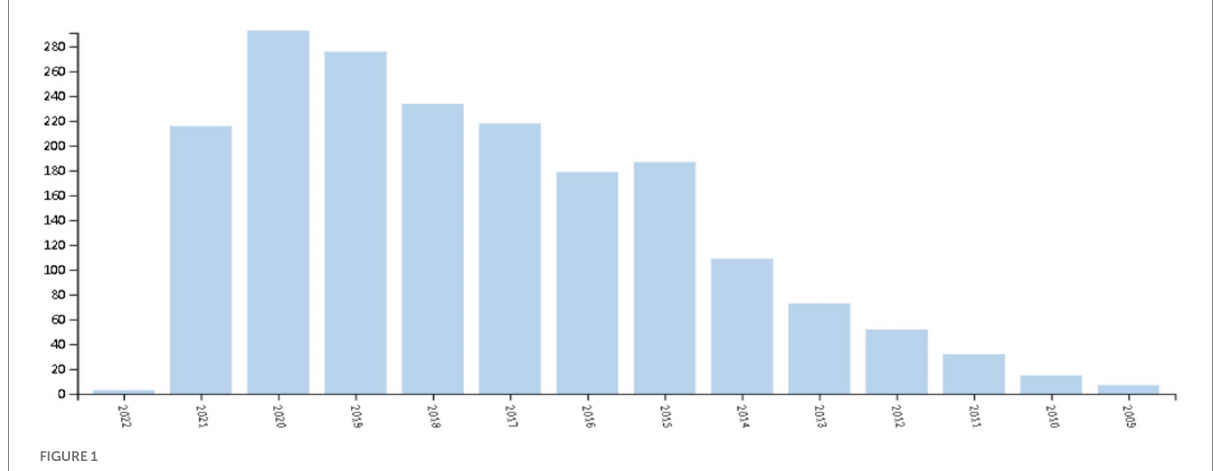
FIGURE 1 The research trend of the use of social media in